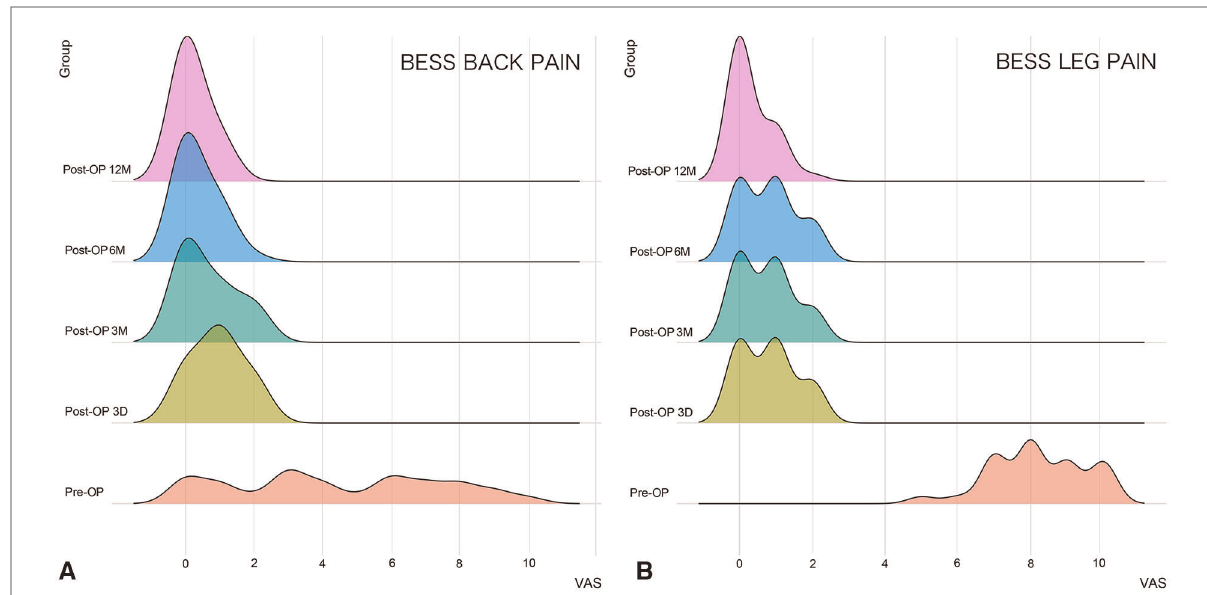
FIGURE 3 ( A ) Comparison of VAS scores for postoperative low back pain in the UBE/BESS group at each time point; no signi fi cant decrease was noted at 3 months postoperatively compared with that at 3 days postoperatively, and no signi fi cant decrease was noted at 12 months postoperatively compared with that at 6 months postoperatively ( P >0.05). Further signi fi cant decreases at 6 and 12 months postoperatively compared with that at 3 days and 3 months postoperatively were observed ( P <0.05). ( B ) On comparing the VAS scores for postoperative leg pain in the UBE/BESS group at each time point, no signi fi cant differences were noted at 3 days, 3 months, and 6 months postoperatively ( P >0.05), and a signi fi cant decrease at 12 months postoperatively compared with that at 3 days, 3 months, and 6 months postoperatively was observed ( P <0.05).